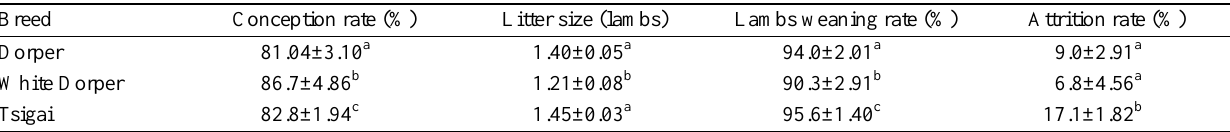
Table 3. Least squares means (±standard error) for reproductive performance and attrition rates in Dorper, White Dorper, and Tsigai ewes